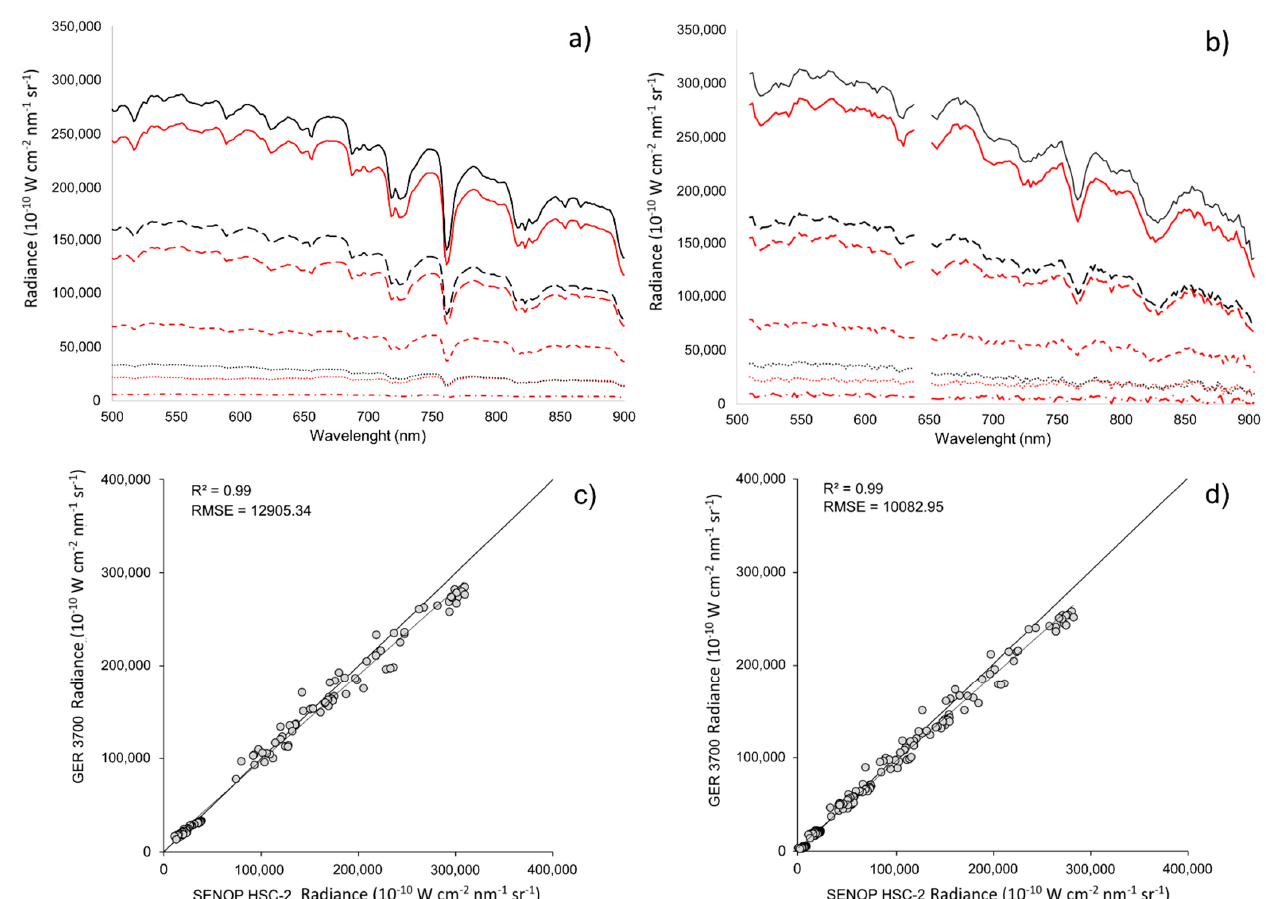
Figure 5. Spectral characterization of OptoPolymer (black lines) and Senop (red lines) reference panels using GER 3700 ( a ) and SENOP HSC-2 ( b ). Scatter plots related to spectral comparison between GER 3700 and SENOP HSC-2 using OptoPolymer ( c ) and Senop ( d ) reference panels legend: 0.97% reflectance (black solid line), 0.56% reflectance (black long-dashed line), 0.10% reflectance (black dotted line), 0.88% reflectance (red solid line), 0.50% reflectance (red long-dashed line), 0.25% reflectance (red dashed line), 0.09% reflectance (red dotted line), 0.02% reflectance (red dotted-dashed line).